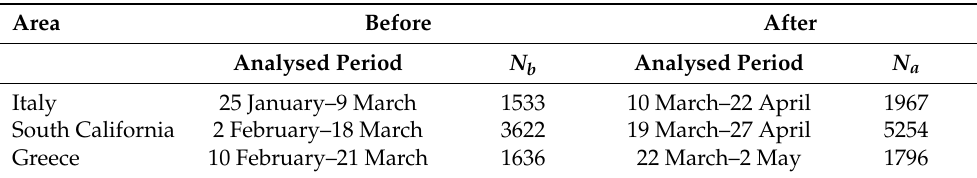
Table 1. The time interval and the number of events before and after the lockdown date for each area here analysed. All the periods refers to 2020. Area Before After Analysed Period N b Analysed Period N a